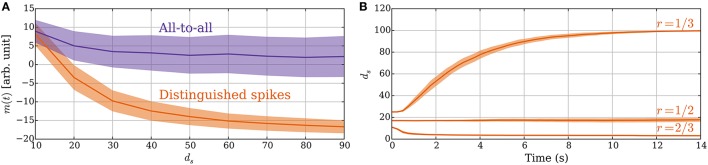
(A) Advantage of DSPs (Section 3.2.5). With DSPs in the model with leak, the variance of the memory trace is considerably smaller than for an all-to-all rule. The curves show the mean memory trace value when varying the number of strong inputs ds in a static setting with ps→w = pw→s = 0. The orange curve corresponds to the SLN rule. The purple curve corresponds to a rule where all pre–post and post–pre spike pairs within an UP phase trigger learning signals. (B) Constant rate input at 40 Hz in the model with leak (Section 3.2.6). The two different sets of plasticity parameters from Table 3 are compared. For each setting, the number of strong synapses ds is initially set in the stable state for the oscillating input. For the r = 1/3 parameters, all the synapses increase their weights since the synapses receive potentiation signals half of the time instead of one-third of the time, which they expect. For the r = 1/2 parameters, there is no such disagreement and for the r = 2/3 parameters it is the opposite and the input weight decreases to a point where activation becomes unreliable. In (A) the mean is taken after a 50-s-simulation over 10 trials, where in each trial samples are taken from all 100 synapses. In (B) the curves show means of 50 trials. In both panels the envelopes represent standard deviation estimates.